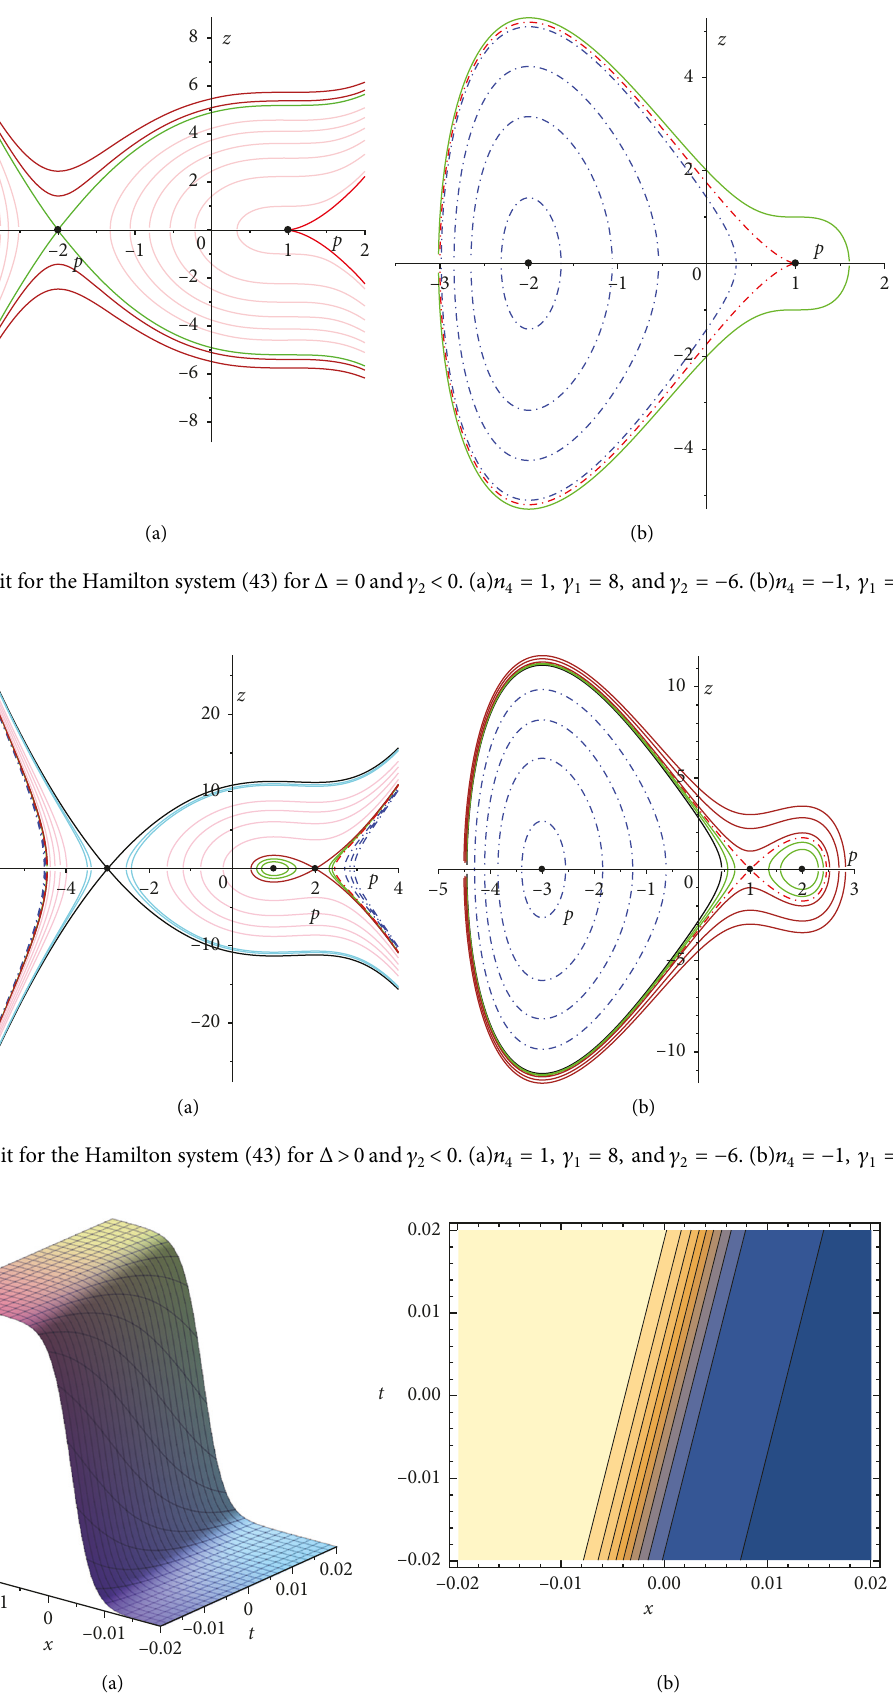
. 1 , h 0 . 002 , k 1 , l 0 0 . 002 , μ 0 . 0001 , ω 1 (cid:31) 0 (cid:31) (cid:31) (cid:31) (cid:31)